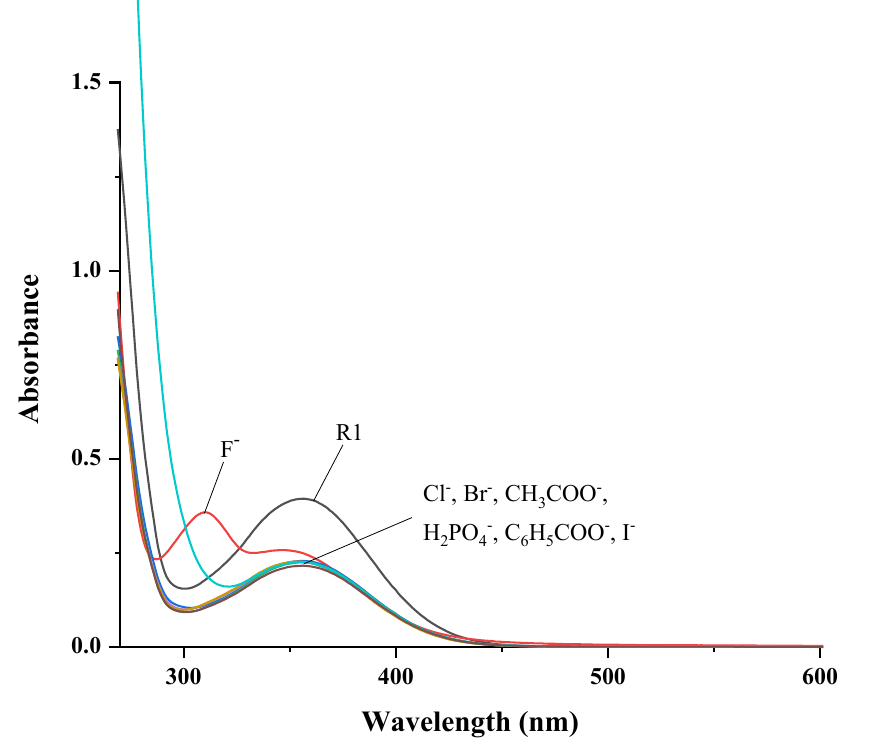
Figure 5. The absorption spectra of sensor R1 (1 × 10 − 4 M) and sensor R1 in DMSO with 80 equivalents of different anions.